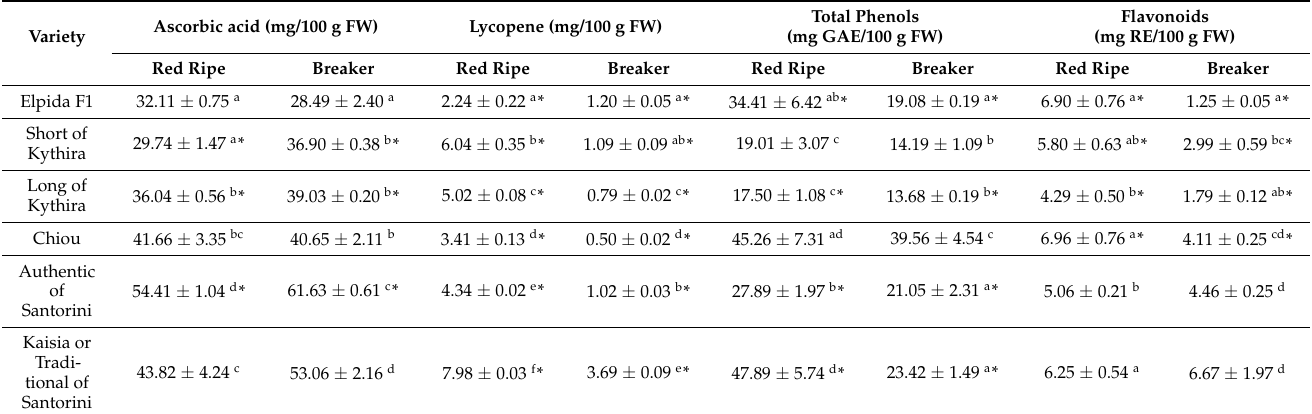
Table 3. Antioxidants content of six tomato varieties at red ripe and breaker ripening